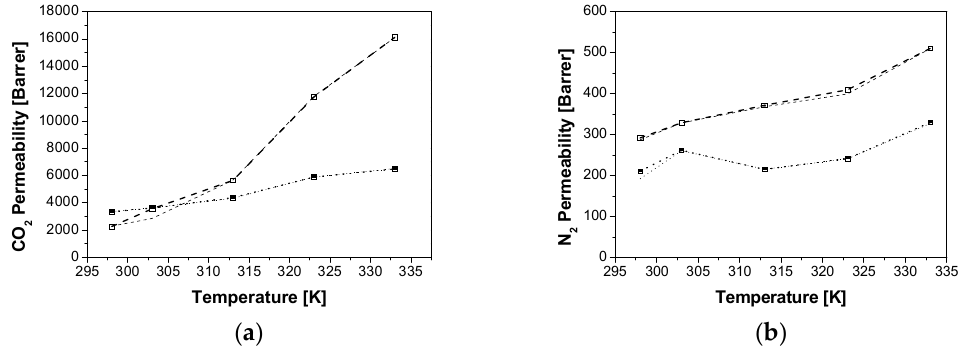
Figure 4. Effect of temperature and zeolite loading on the CO 2 ( a ) and N 2 ( b ) permeability through CHA/PTMSP MMMs: Thin lines correspond to the reduced mobility modified Maxwell model and thick lines to the extended modified Maxwell model. Dash, dot and continuous patterns, and void, half-filled and full symbols, refer to 5 wt %, 10 wt % and 20 wt % zeolite loading, respectively.